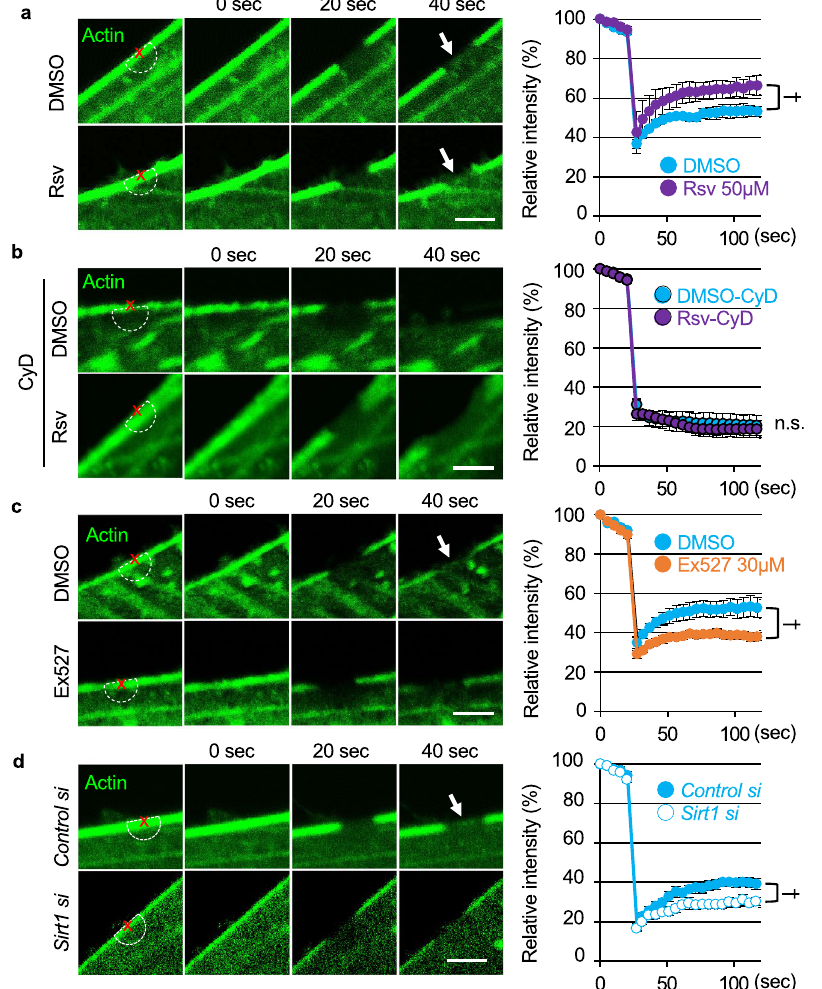
Figure 3. SIRT1 is required for actin accumulation at the damaged site. ( a – d ) Accumulation of actin at the laser injured site measured by fluorescence intensity of actin-GFP indicated as semicircle in dotted lines (white; diameter 2 μm). Left panels show representative images, and arrows indicate the accumulation of actin at the injured sites. The right panel shows the time course of the relative intensity of actin-GFP. ( a ) DMSO- (upper) and Rsv- (lower) treated C2C12 cells (n = 10). ( b ) Effect of the depolymerizing condition (cytochalasin D at 10 μM for 30 min) on the promotion of actin accumulation by Rsv (n = 4). ( c ) Effect of a SIRT1 inhibitor, Ex527 (30 μM for 12 h), in C2C12 cells (n = 5). ( d ) Effect of Sirt1 siRNA on actin accumulation at the injured site (n = 6). Data are represented as means ± SEM. A significant difference was determined by a two-tailed Student’s t -test. † indicates P < 0.05 at the last time point (120 s). n.s. = not significant. CyD = cytochalasin